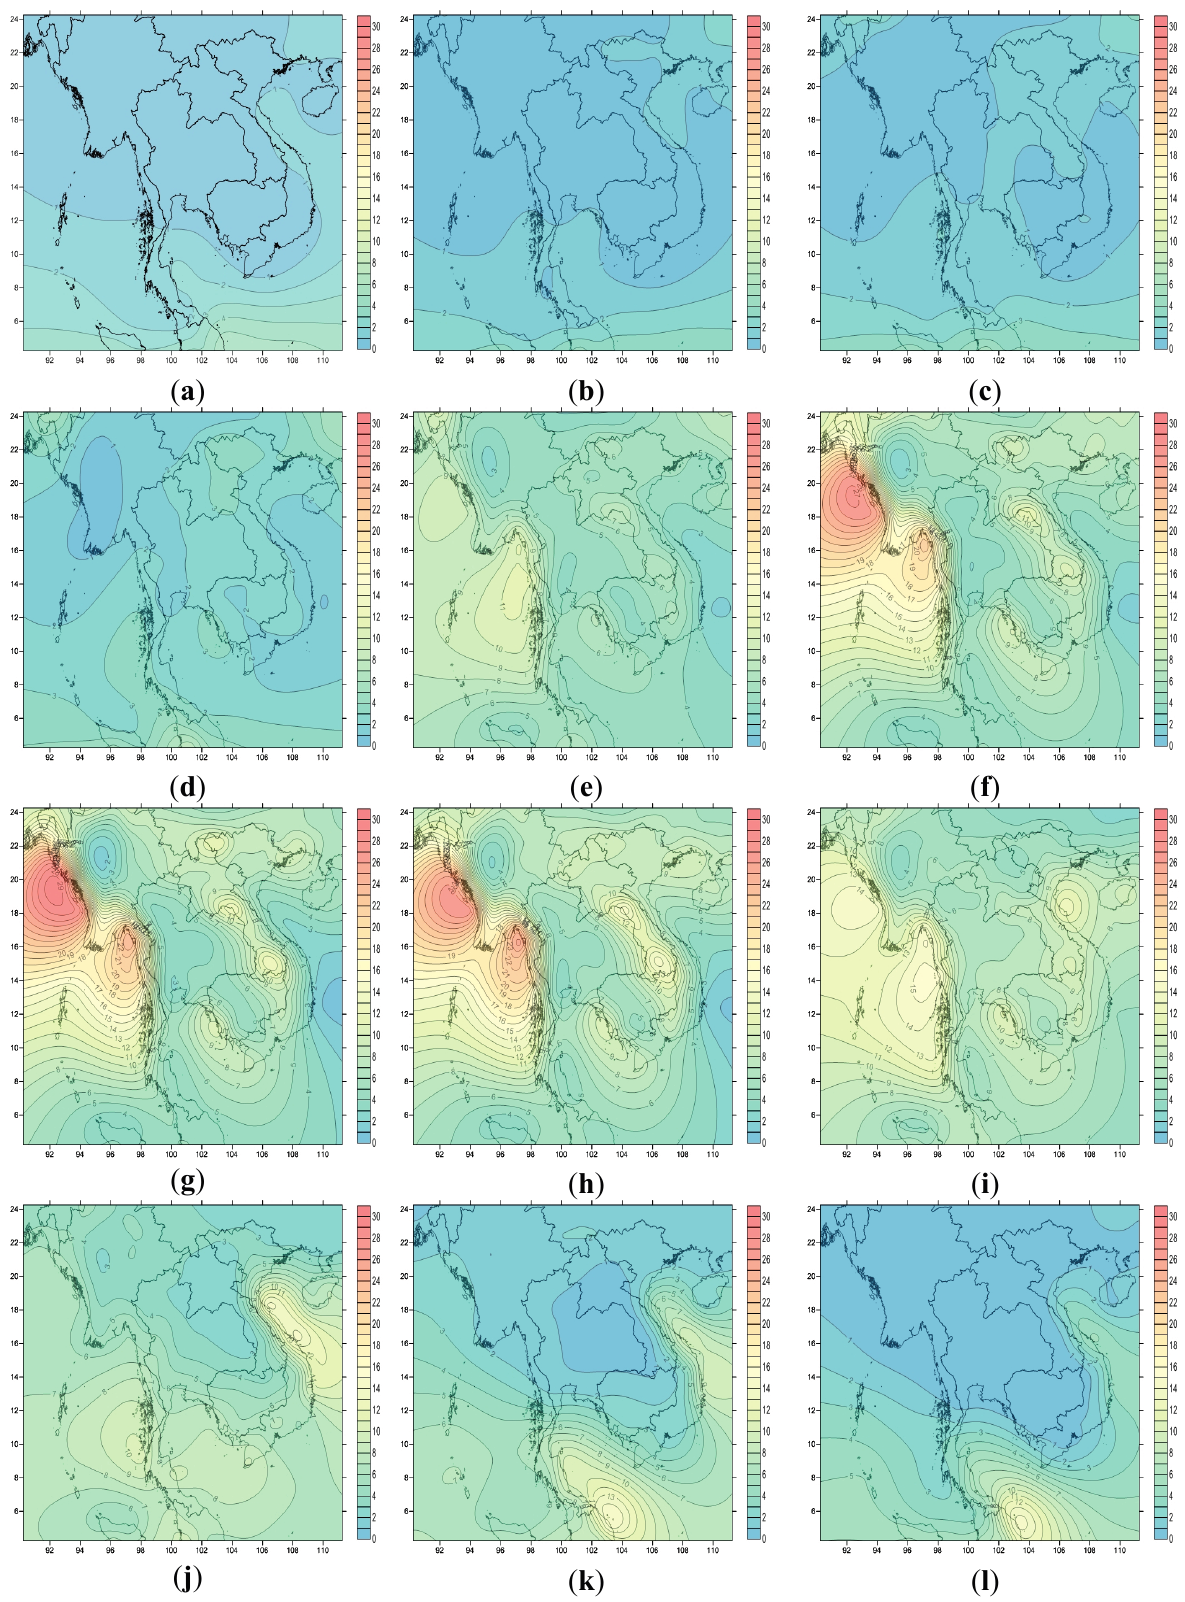
Figure 2. Spatial analysis of monthly mean rainfall over the Indochina Peninsula (mm/day). ( a ) January; ( b ) February; ( c ) March; ( d ) April; ( e ) May; ( f ) June; ( g ) July; ( h ) August; ( i ) September; ( j ) October; ( k ) November; ( l )